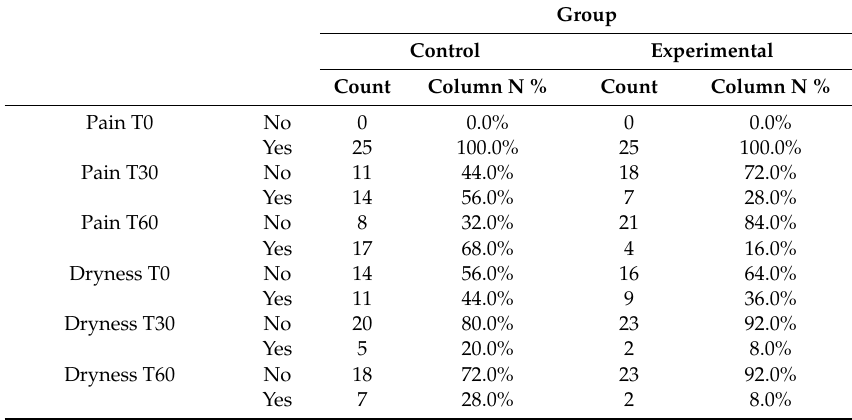
Table 3. Distribution of pain and dryness between groups before treatment (T0), after 30 days of treatment (T30) and after 30 days after treatment had stopped (T60).